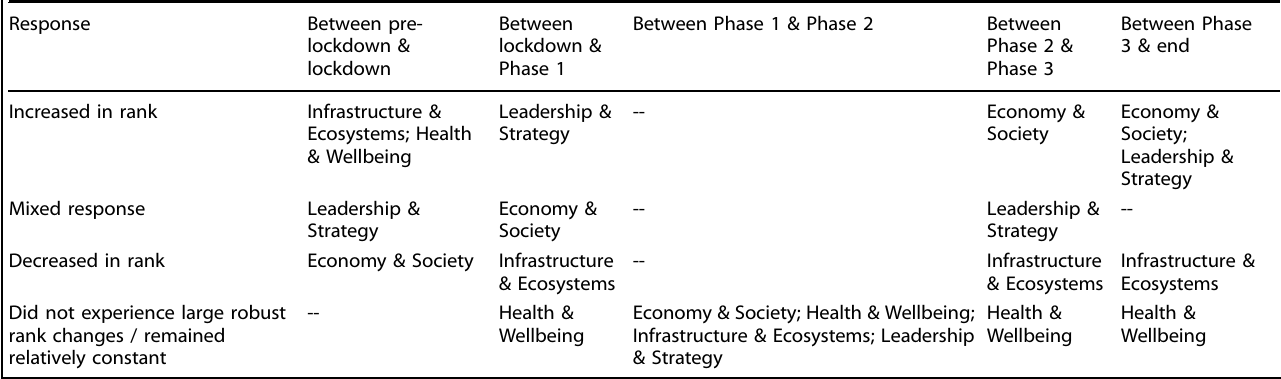
Table 5. Trends in changes to Tasks throughout the modelled period, by 100RC category, based on only Tasks with large robust rank